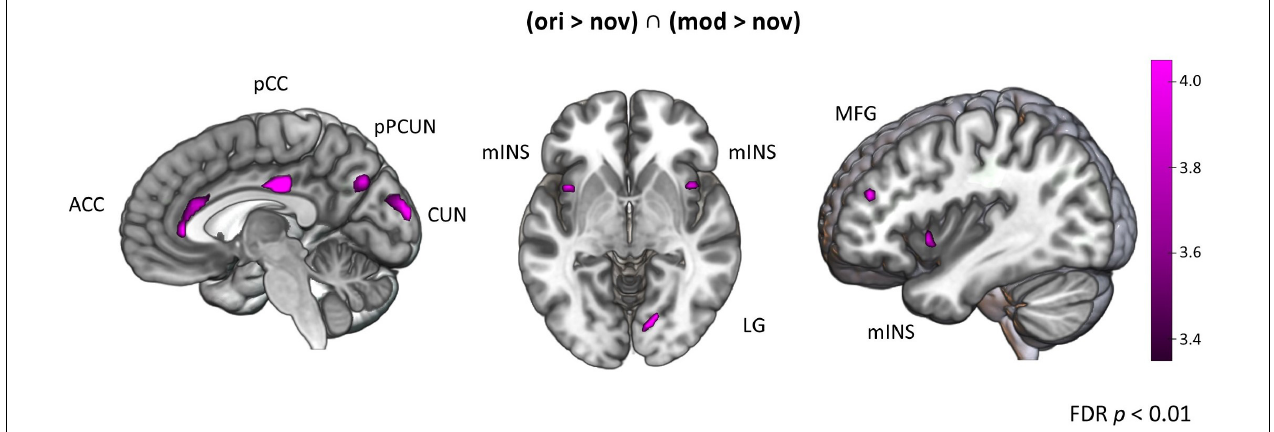
FIGURE 6 | Brain activation for episodes. Areas activated for action videos showing formerly experienced stories contrasted with novel stories [( ori > nov ) ∩ ( mod > nov )]. FDR-corrected t -map ( p < 0.05). CUN, cuneus; PCUN, precuneus; pCC, posterior cingulate cortex; ACC, anterior cingulate cortex; MFG, middle frontal gyrus; mINS, mid-Insula; LG, lingual gyrus.